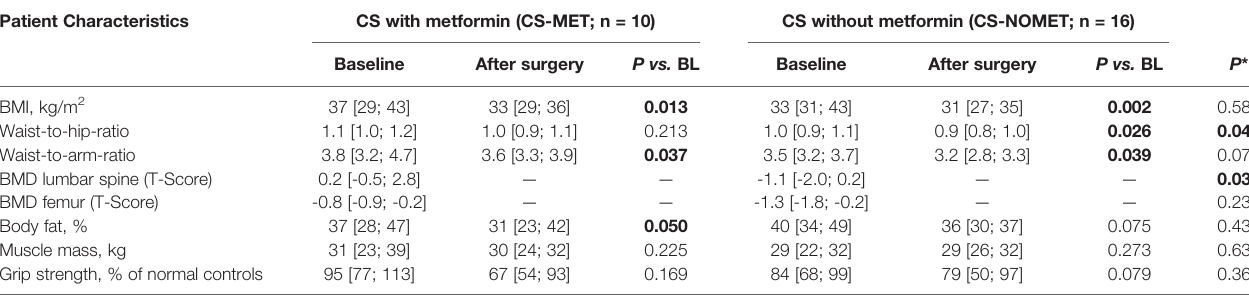
TABLE 2 | Anthropometric and musculoskeletal characteristics at baseline and 1-year follow-up of patients with CS ± metformin. Patient Characteristics CS with metformin (CS-MET; n =